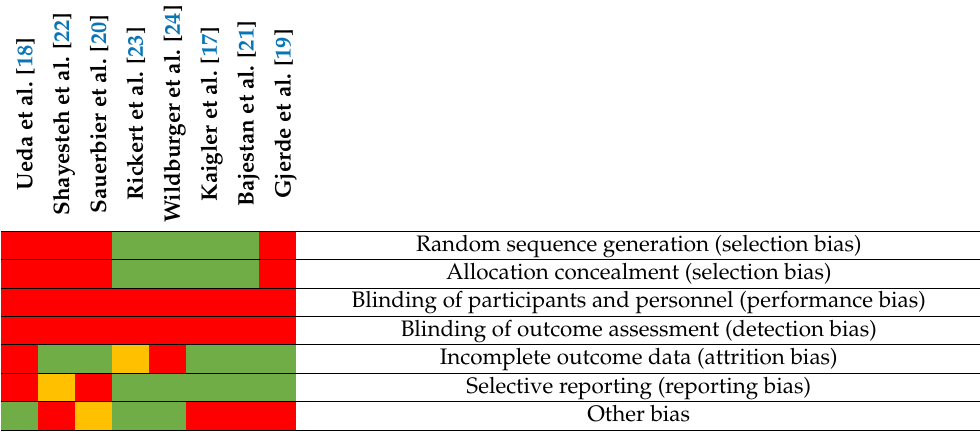
Table 2. Quality evaluation of articles according to Risk of Bias in Non-randomized Studies of Interventions (ROBINS-I) assessment tool [15].